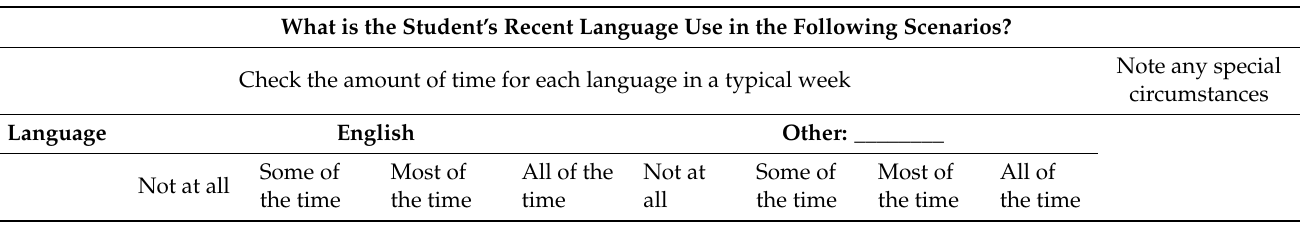
Table 4. Language Use.